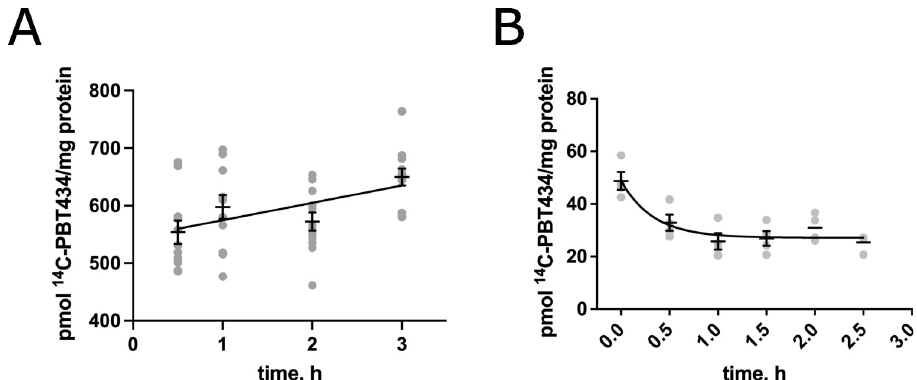
Fig 3. 14 C-PBT434 accumulation and efflux from hBMVEC. hBMVEC were loaded with 20 μ M 14 C-PBT434 at 37˚C for 0.5-3h ( A ) and the amount of 14 C-PBT434 accumulated in the lysates at each time point was plotted, n = 12 experimental replicates/time point. The rate of 14 C-PBT434 accumulation from 0.5-3h was calculated using linear regression analysis to be 30.1 ± 9.8 pmol/mg/h, reaching an endpoint of 650 ± 51 pmol/mg protein, or approximately 19–24 μ M in the cell. For efflux, hBMVEC were loaded with 20 μ M 14 C-PBT434 at 37˚C for 30min and then incubated in efflux medium at 37˚C for 0–2.5h, and the amount of 14 C-PBT434 remaining in lysates at each time point was plotted, n = 3–4 experimental replicates/time point ( B ). The line is a standard exponential fit to the data. The apparent plateau estimated by this fit is 27 ± 4 pmol/mg protein, or ~0.5–0.6 μ M remaining in the cells. corresponding efflux (transcellular flux) was quantified by the appearance of 14 C-PBT434 in the efflux chamber ( Fig 4 panels B and D ). The rates of these processes are provided in Table 1 . The mass data illustrated in Fig 4 (panels B and D ) show that the net flux of PBT434 across this model blood-brain barrier was the same in the two directions. There were 976 ± 185 pmol 14 C-PBT434 accumulated in the basal chamber ( Fig 4B ) and 1033 ± 210 pmol quantified in the basal chamber ( Fig 4D ). This near equivalence was reflected also in the closely similar rates of PBT434 efflux at the two barrier membranes ( Table 1 ). However, there was a signifi- cantly greater uptake of PBT434 at the basolateral membrane in this barrier model as illus- trated by the ~50% greater loss of compound from the basal chamber ( Fig 4C ) that corresponded to a ~40% greater rate of apparent cell uptake ( Table 1 ). A more robust uptake would be predicted to result in greater accumulation. In fact, analysis of the cells at 3h showed that they retained ~6 μ M PBT434 irrespective of the flux direction. The values were 8.1 ± 1.3 μ M (apical to basal) and 4.7 ± 1.2 μ M (basal to apical). As noted above, this analysis follows washing of the cells prior to lysis and quantification of total cell protein and 14 C-PBT434. In addition, the medium in the apical chamber contained RPMI plus 10% FBS and 10% NuSerum whereas the basal, ‘brain’ chamber contained only RPMI (Methods). A reasonable inference was that the apparently greater ‘uptake’ at the basal membrane reflected a cell surface adsorp- tion of PBT434 that was limited in the apical chamber by the presence of protein components in the serum. Upon washing the cells for accumulation of PBT434, this adsorbed material (that registered as ‘uptake’) was removed. Repeating this flux experiment but with serum in the basal chamber demonstrated that, indeed, serum suppressed this likely cell surface PBT434 adsorption ( S2 Fig ).